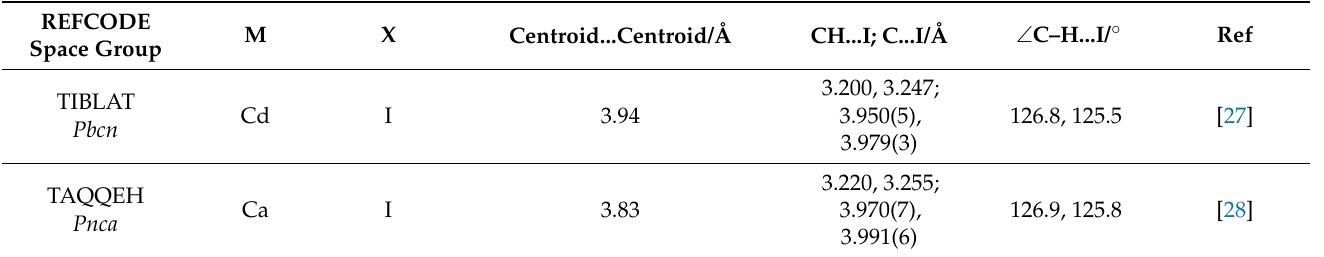
Figure 4. Packing interactions in cis- [Cd(bpy) 2 I 2 ] (CSD refcode TIBLAT [27]): ( a ) π -stacking interaction with H3...I and H4...I contacts (in red), and ( b ) assembly of a 1D-chain. Table 3. Metric parameters for the face-to-face π -stacking and CH...X contacts in the packing motif in cis- [M(bpy) 2 I 2 ] (M = Cd, Ca). See Figure 4a.